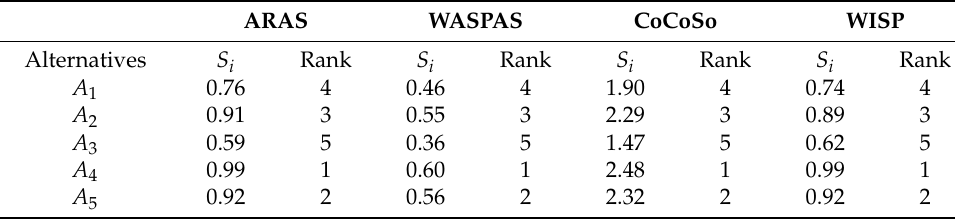
Table 11. Ranking of alternatives using grey WS, WP, WASPAS and CoCoSo methods. ARAS WASPAS CoCoSo WISP